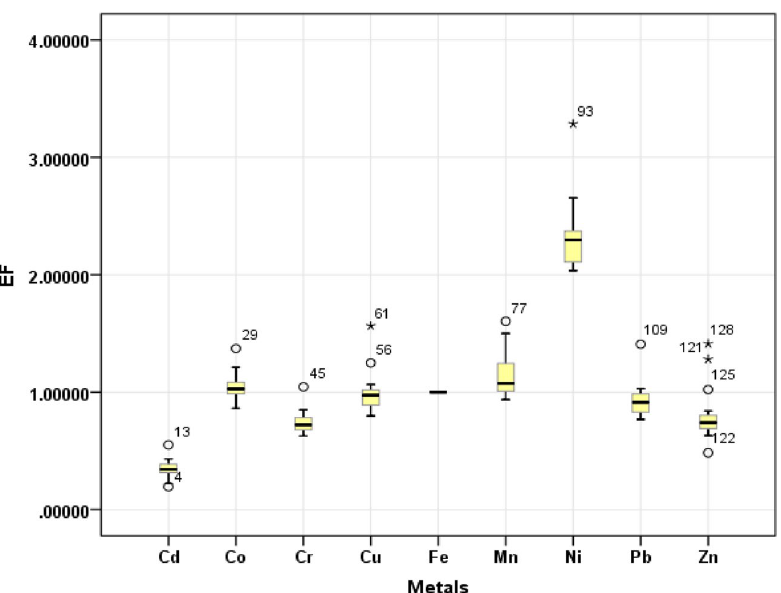
Figure 4. Box plots of EF values for TEs in the soils of